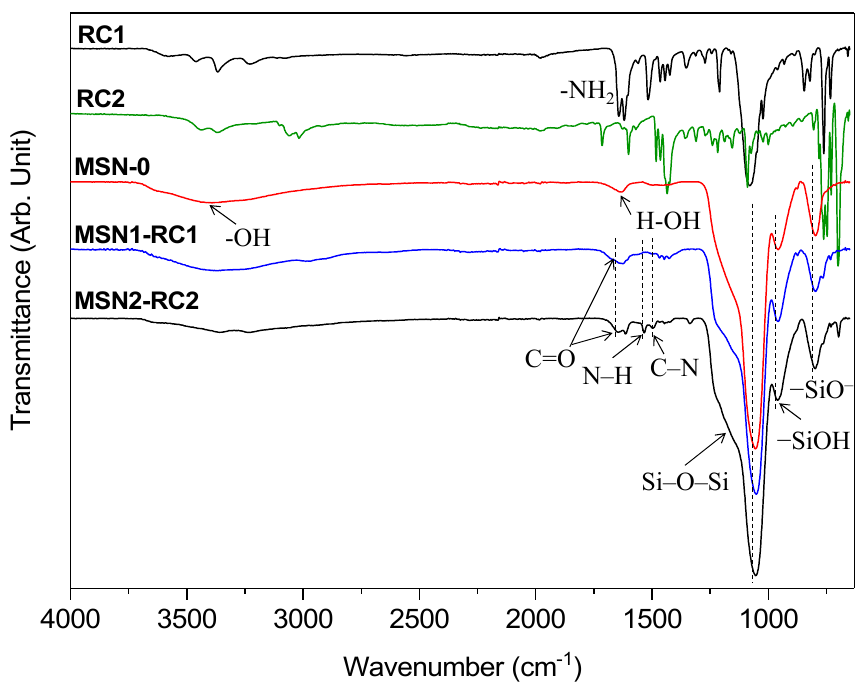
Figure 5. FTIR spectra of the ruthenium (II) complexes RC1 and RC2, of the calcined MSN-0, and of both final functionalized mesoporous silica nanomaterials MSN1-RC1 and MSN2-RC2, between 600 and 4000 cm − 1 : − SiO – (795 cm –1 ), − SiOH (956 cm –1 ), − SiOSi − (1052 and 1231 cm –1 ), C − N (1495 cm –1 ), N − H (1530 cm –1 ), H − OH (1640 cm –1 ) C = O (1600-1700 cm –1 ), − NH 2 (1615 cm –1 ), and –OH (3260 cm –1 ).